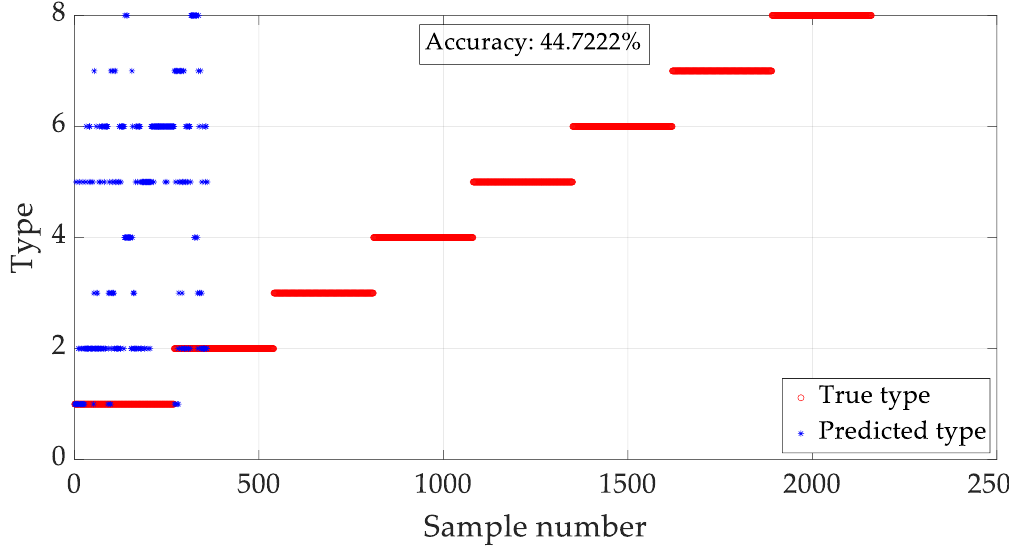
Figure 10. The process of classification using SVM.